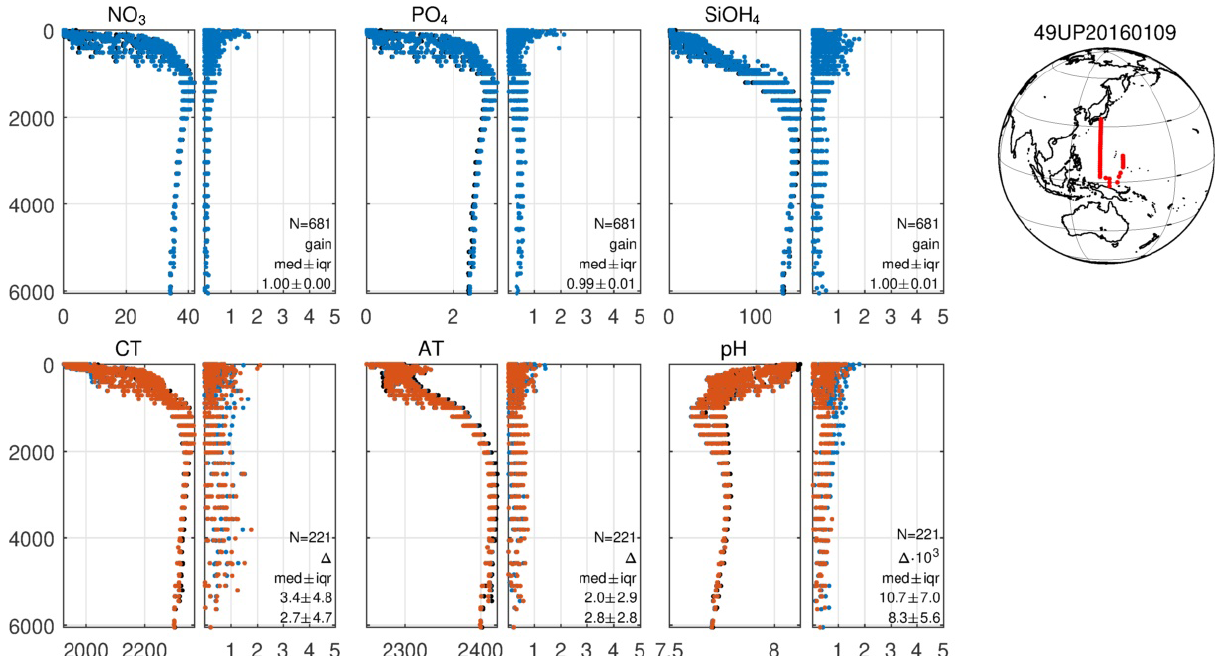
Figure 5. Example summary figure for CANYON-B and CONTENT analyses for 49UP20160109. Any data from regions where CONTENT and CANYON-B were not trained are excluded (in this case, the Sea of Japan). The top row shows the nutrients and the bottom row the seawater CO 2 chemistry variables (note, different abbreviations for TCO 2 (CT) and TAlk (AT)). All are shown versus sampling pressure (dbar) and the unit is micromoles per kilogram for all except pH, which is unitless. Black dots (which to a large extent are hidden by the predicted estimates) are the measured data, blue dots are CANYON-B estimates, and red dots are the CONTENT estimates. Each variable has two figure panels. The left shows the depth profile while the right shows the absolute difference between measured and estimated values divided by the CANYON-B/CONTENT uncertainty estimate, which is determined for each estimated value. These values are used to gauge the comparability; a value below 1 indicates a good match as it means that the difference between measured and estimated values is less than the uncertainty of the latter. The statistics in each panel are for all data deeper than 500dbar and N is the number of samples considered. The median (med) ratio between measured and estimated values and its interquartile (iqr) range are given for the nutrients. For the seawater CO 2 chemistry variables the numbers on each panel are the median difference between measured and predicted values for CANYON-B (upper) and CONTENT (lower). Both are given with their interquartile